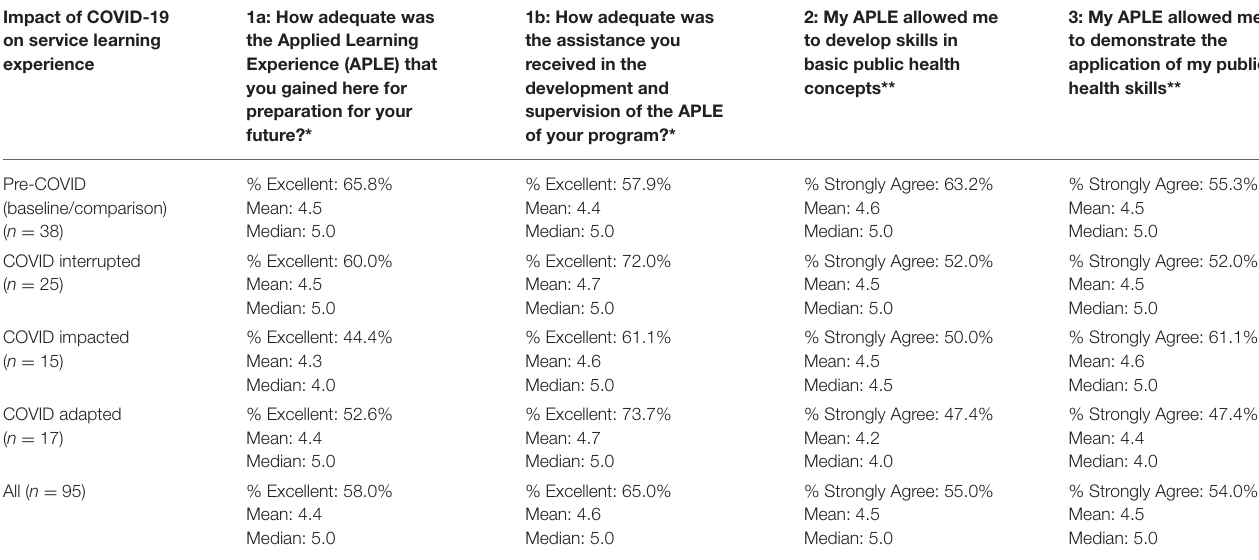
TABLE 3 | Summary of exit survey data, reported by PH 485 student enrollment semester. Impact of COVID-19 on service learning